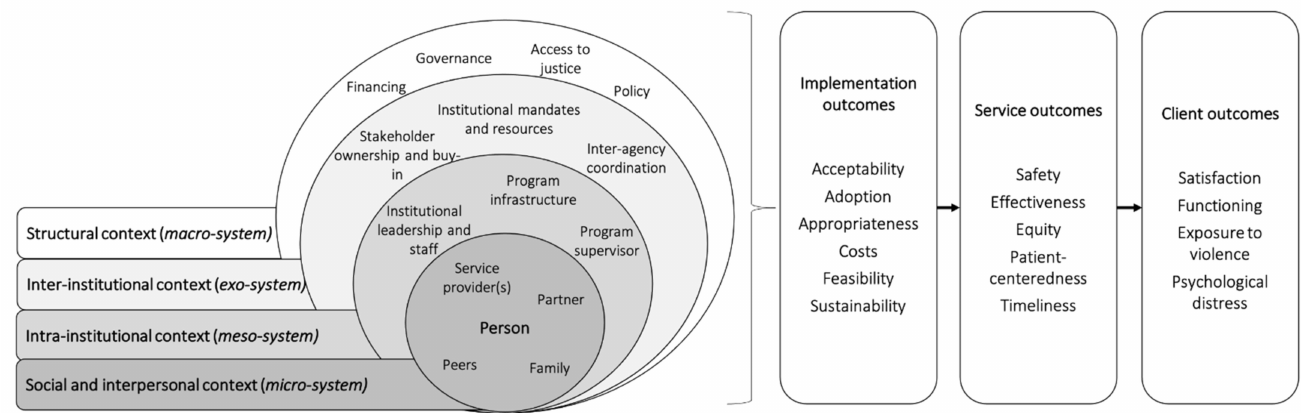
Figure 1. Multilevel determinants of integrated service delivery for IPV and mental health in Nyarugusu Refugee Camp (adapted from Proctor et al., 2011; Woolcott et al., 2019)